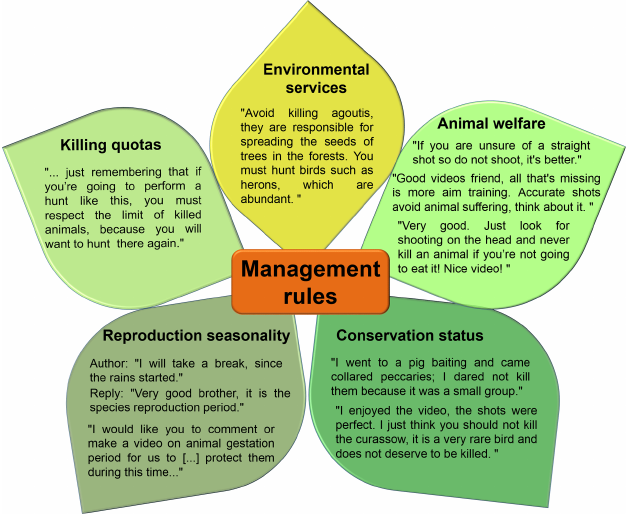
Fig. 8 . A diagram illustrating the five management rules possibly adopted by sport hunters in Brazil and some respective comments showing hunting attitudes based on these